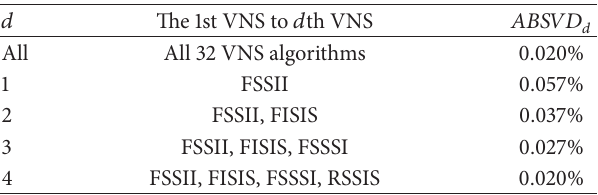
Table 3: The 1st VNS to d th VNS algorithms and 𝐴𝐵𝑆𝑉𝐷 𝑑 value in each iteration of Algorithm 4 based on results from Table 1.